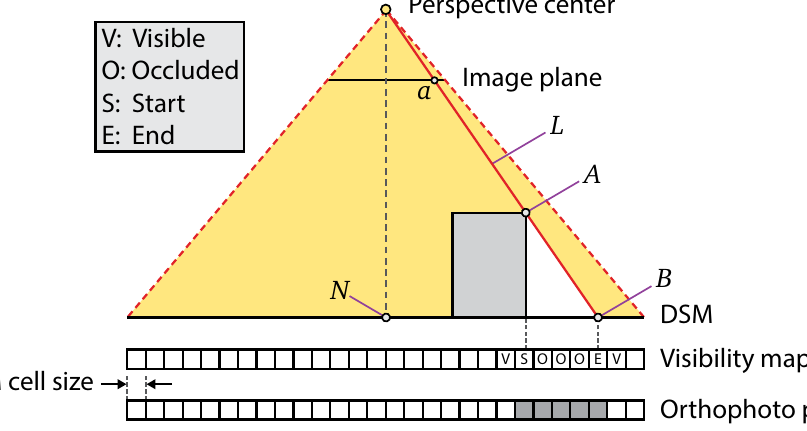
Figure 5. Principle of occlusion detection using the height-gradient-based